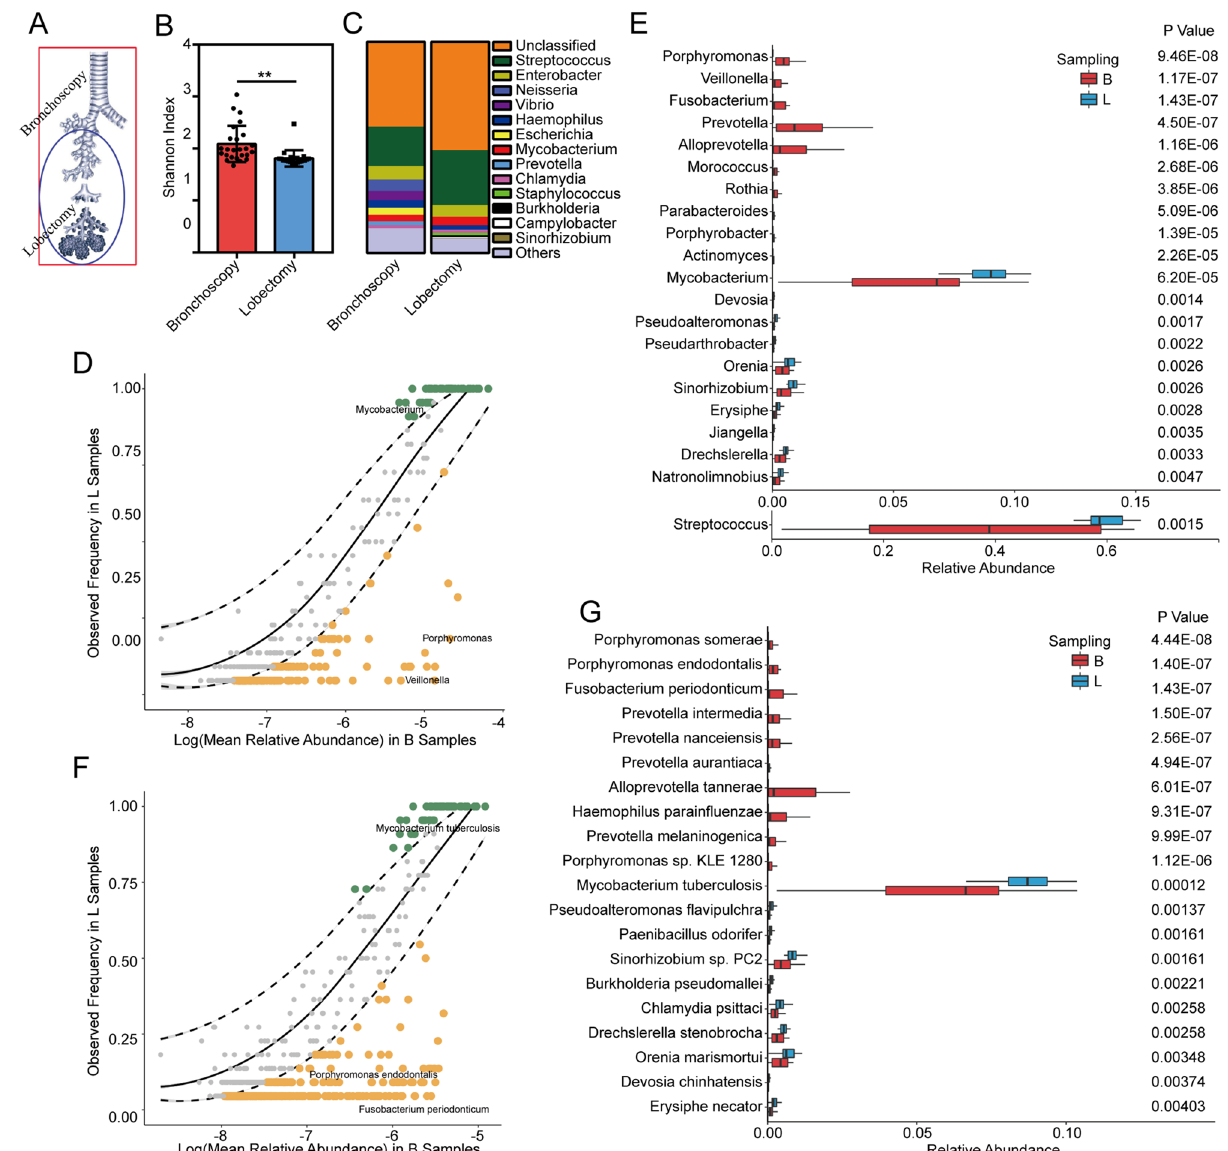
Figure 2. The microbial composition varied in different anatomy sites. ( A ) The schematic diagram of the sampling sites. The squared area represents the extent of bronchoscopy sampling area. The circled area covers the sampling area from lobectomy. ( B ) The Shannon diversity index of bronchoscopy samples and lobectomy samples. Difference between sampling methods was determined by Student t test. ***p < 0.001. ( C ) Taxonomic composition at phylum level in bronchoscopy and lobectomy samples. Neutral model applied to compare the overall lung microbiota composition at genus level ( D ) and at species level ( E ). Dashed lines represent 95% confidence intervals around the model prediction (solid line). The green dots that are beyond the 95% confidence intervals are the OTUs whose observed frequency in lobectomy samples is greater than the model prediction (bronchoscopy samples). The dark golden points that are beyond the 95% confidence intervals are the OTUs whose observed frequency in lobectomy samples is less than the model prediction (bronchoscopy samples). ( F )Taxonomic composition of lobectomy samples at genus level in NSCLC patients and non-cancer controls. The differential genes between NSCLC patients and non-cancer controls in lobectomy samples were identified by Wilcoxon rank-sum test (p < 0.05). ( G ) Taxonomic composition of lobectomy samples at genus level in NSCLC patients and non-cancer controls. The differential genes between NSCLC patients and non- cancer controls in lobectomy samples were identified by Wilcoxon rank-sum test (p < 0.05). B bronchoscopy samples, L lobectomy